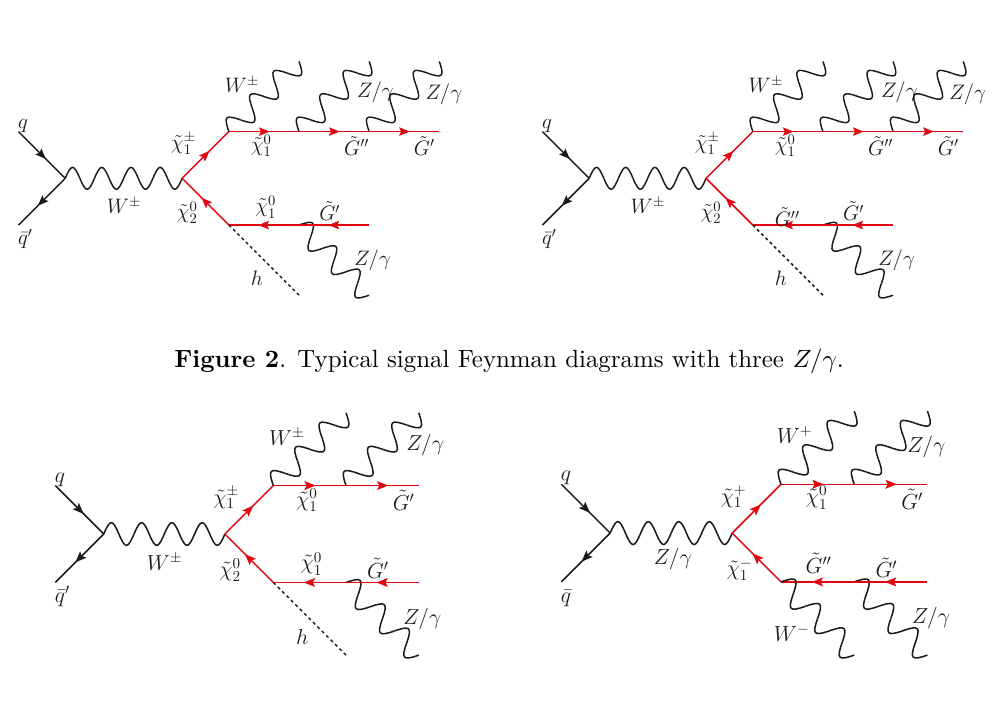
Figure 3 . Typical signal Feynman diagrams with two Z/γ